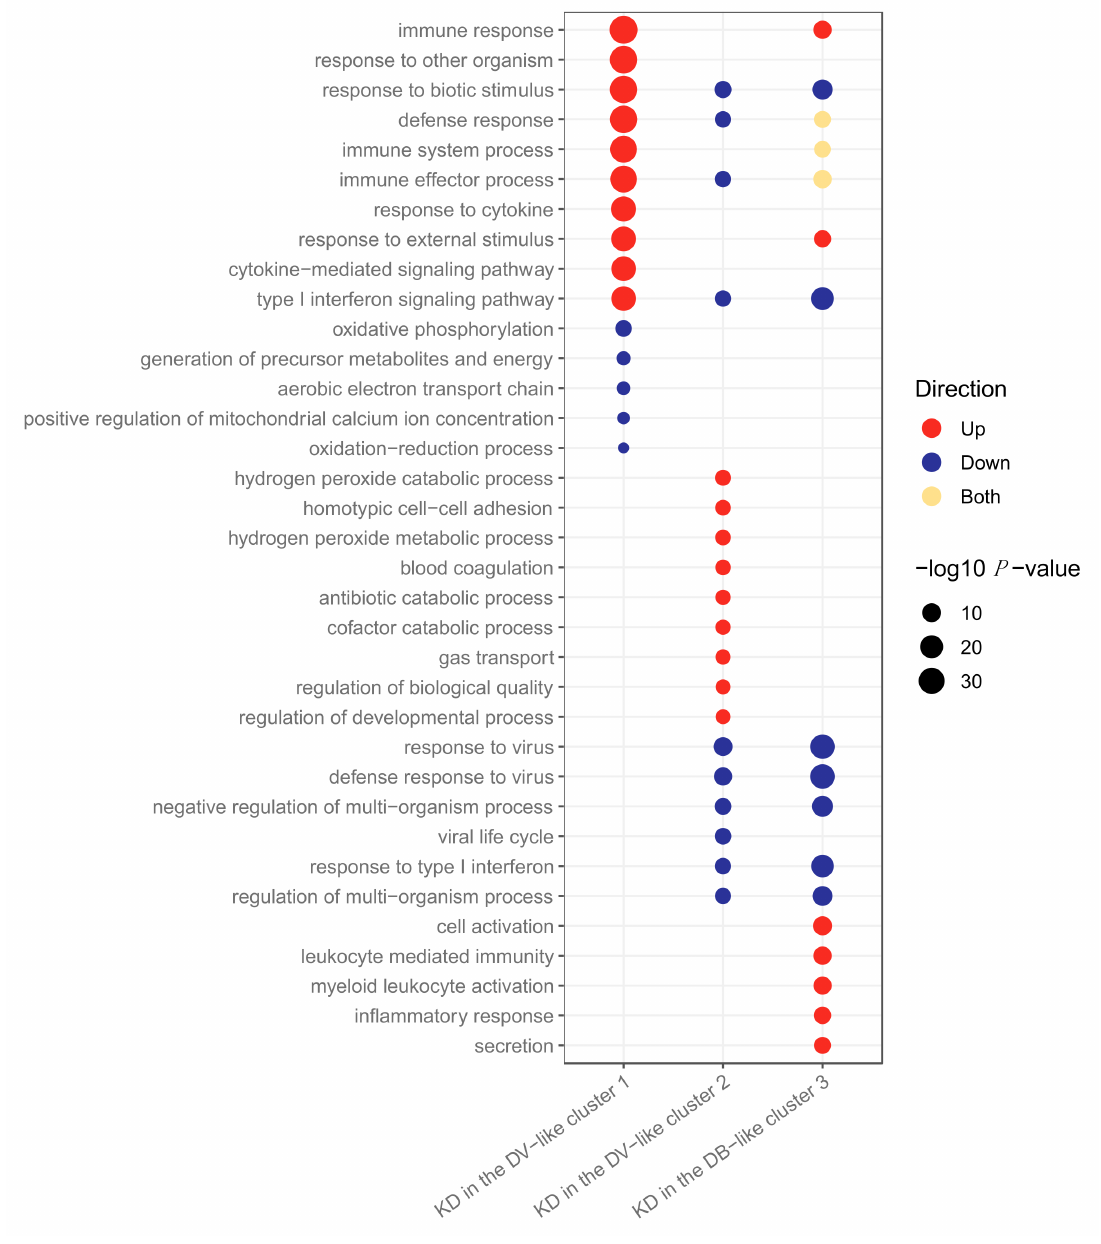
Figure 3. Pathways upregulated and downregulated in the KD patients in clusters 1, 2 and 3 for the transcriptomic dataset. Clusters were identified using K -Means applied to KD, DB and DV patients. KD, DB and DV represent Kawasaki Disease, definite bacterial, and definite viral, respectively. There were 151, 52 and 137 pathways upregulated in clusters 1, 2 and 3, respectively, and 5, 66 and 137 pathways downregulated in clusters 1, 2 and 3,